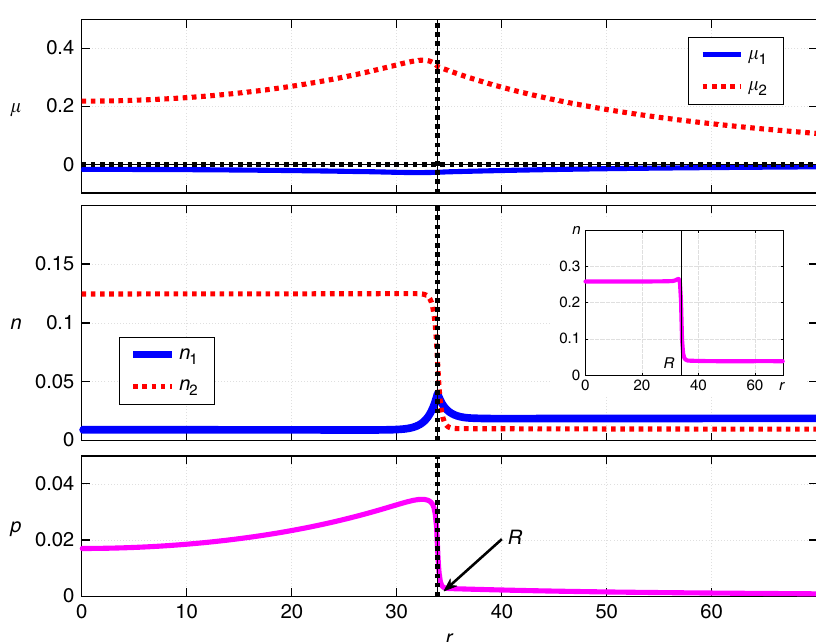
Fig. 1 Stationary droplet solution, 1st order reaction case. Shown are the radial-coordinate dependences of the local chemical potentials μ i ( i = 1, 2), concentrations n i ( i = 1, 2), and pressure p for a stationary, spherically symmetric cluster of radius R , as obtained by solving the reaction-diffusion scheme þ 2 n in Eq. (7). The inset shows the r -dependence of the total amount of the solute, n (cid:4) n . The following parameter values are employed: 1 2 κ ð d Þ ¼ κ ð d Þ ¼ κ ð m Þ ¼ κ ð m Þ ¼ 40, m ð d Þ ¼ m ð m Þ ¼ 52 : 36, m ð d Þ ¼ m ð m Þ ¼ 500, n ð d Þ ¼ 0 : 01, n ð d Þ ¼ 0 : 12, n ð m Þ ¼ 0 : 02, n ð m Þ ¼ 0 : 01, D ð d Þ ¼ 0 : 33, D ð d Þ ¼ 0 : 25, 1 1 1 1 1 1 1 2 2 2 2 2 2 2 ¼ 1, D ð m Þ ¼ 0 : 76, k ð d Þ ¼ 0 : 001, k ð d Þ ¼ 0 : 000077, k ð m Þ ¼ 0 : 000038, k ð m Þ ¼ 0 : 000077, Δ g = 0.01, k z ¼ 0 : 00005, k z ¼ 0 : 00003. The units are D ð m Þ 1 1 1 1 2 2 2 2 arbitrary; the unit of length can be thought of as roughly comparable to molecular dimensions and the unit of energy to k B T . The values for the rate coef fi cients and diffusivities were chosen to yield values for the cluster size comparable to those seen in protein